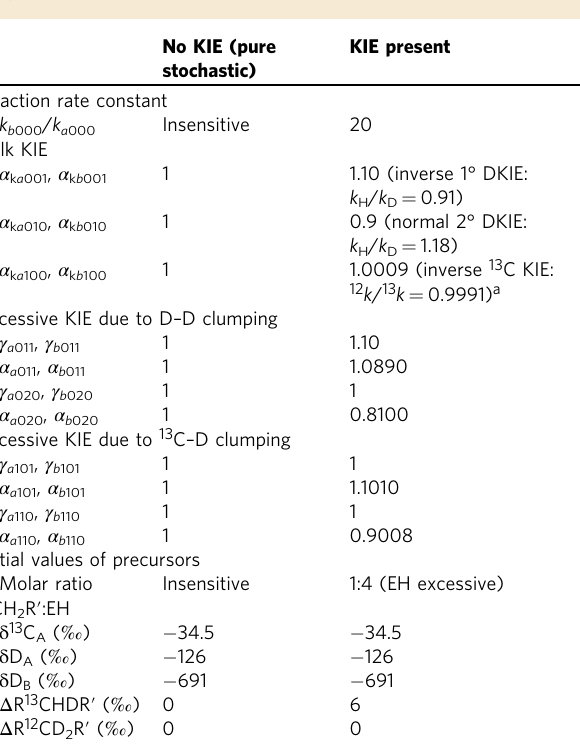
Table 1 Parameters of numerical simulations on the isotopic fractionation of CH 4 during hydrogen biodegradation (Fig.